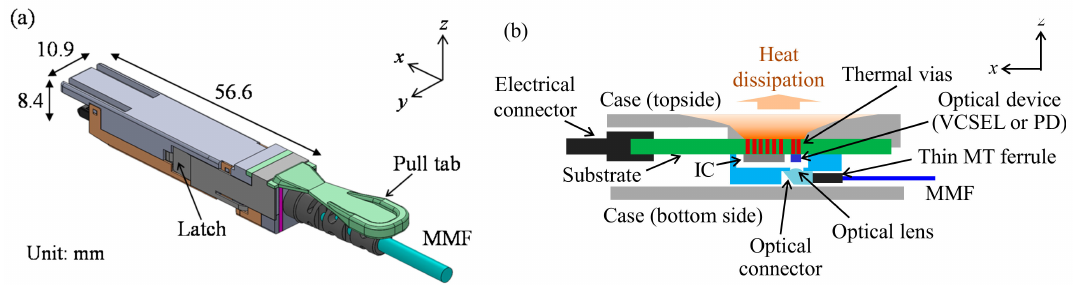
Figure 1. Structure of the proposed active optical cable (AOC) ( a ) whole view and ( b ) cross sectional view. MMF, multi mode fiber; IC, integrated circuit; VCSEL, vertical cavity surface emitting laser; PD, photodiode; MCU, micro control unit; EEPROM, electrically erasable programmable read-only memory; MT, mechanical transfer; TIA, transimpedance